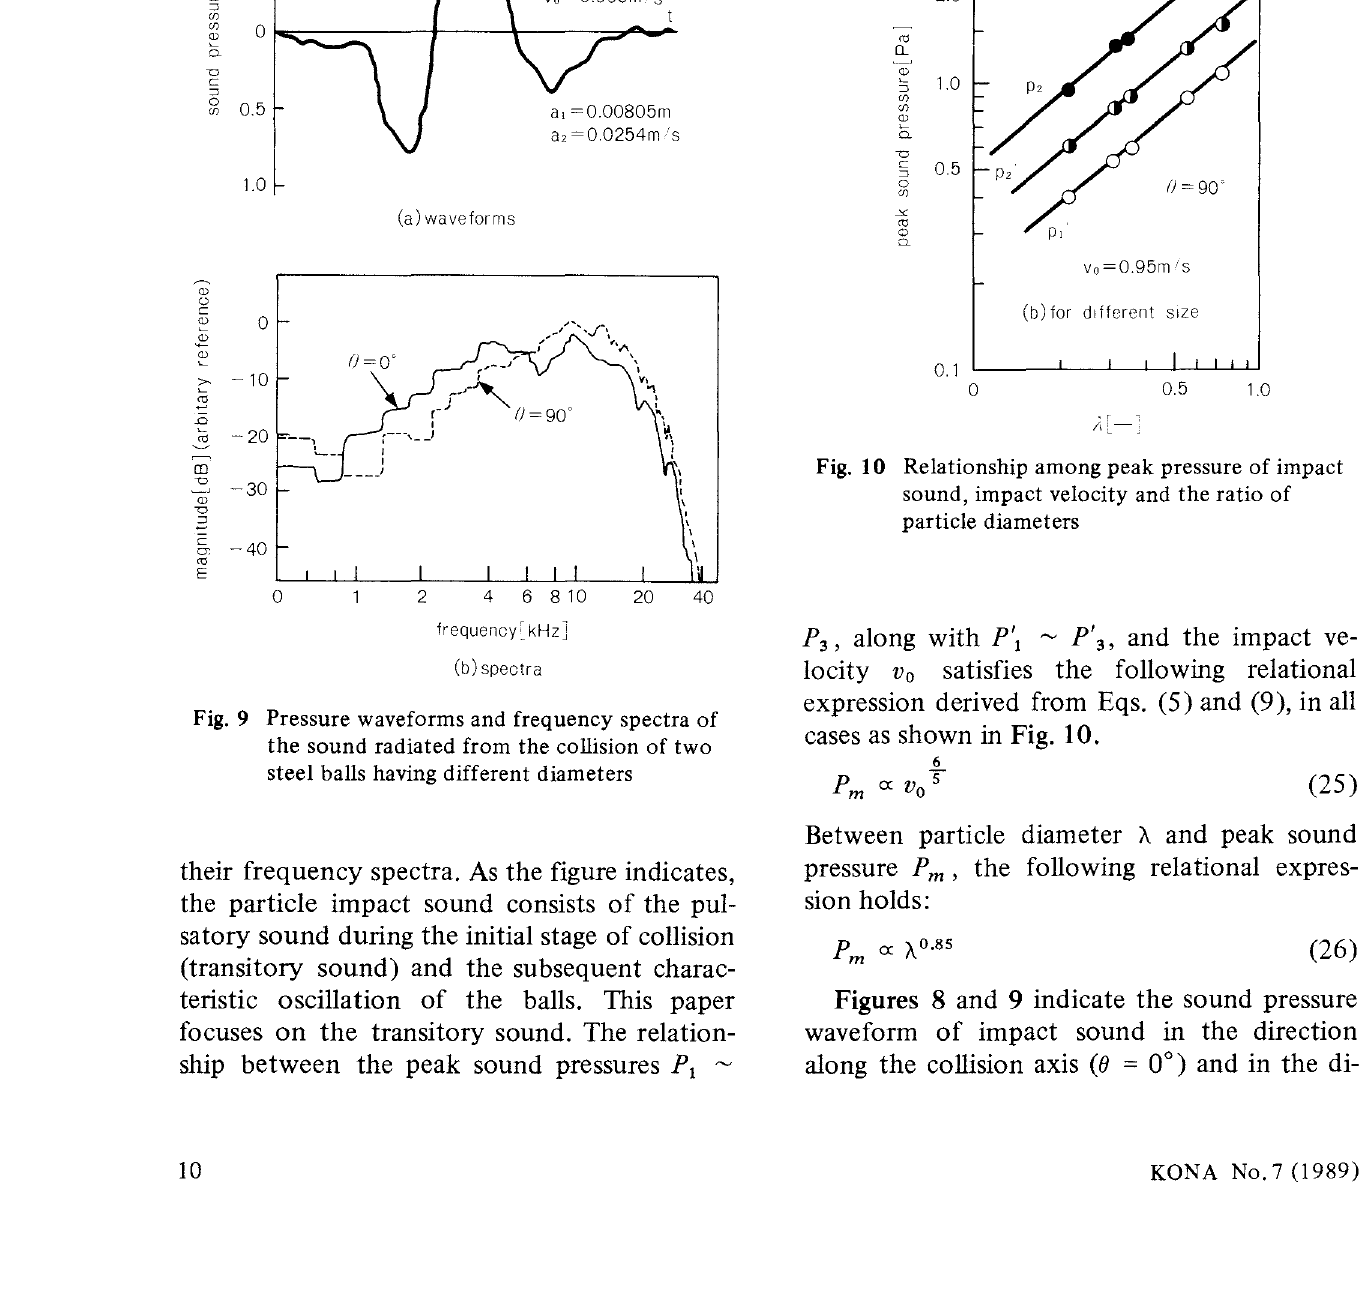
Fig. 10 Relationship among peak pressure of impact sound, impact velocity and the ratio of particle